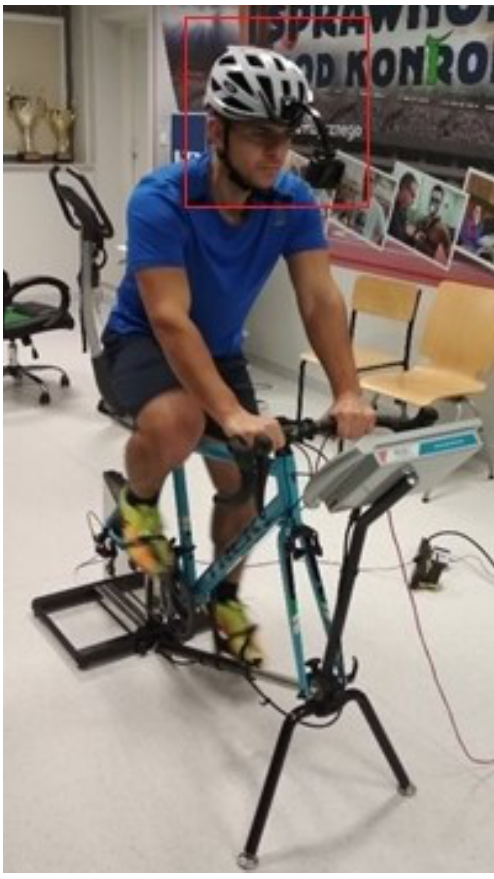
Figure 1. Stand for carrying out the oxygen progressive